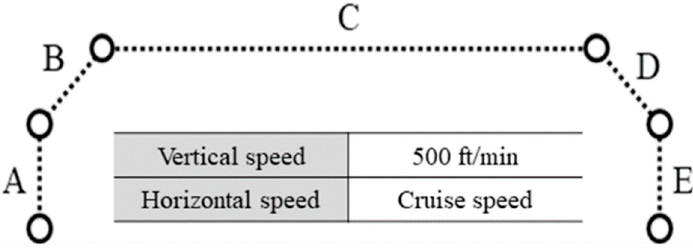
Appl. Sci. 2020 , 10 , 5112